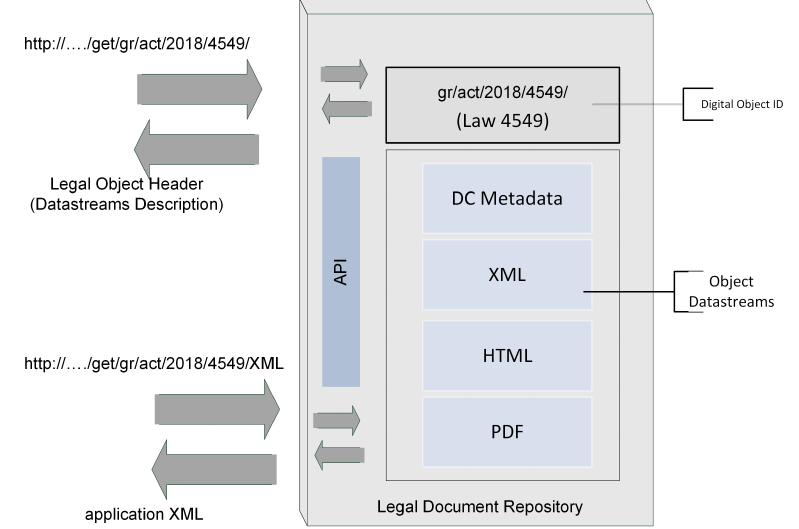
Figure 5. REST based access requests to a Legal document and its components in the Legal Document